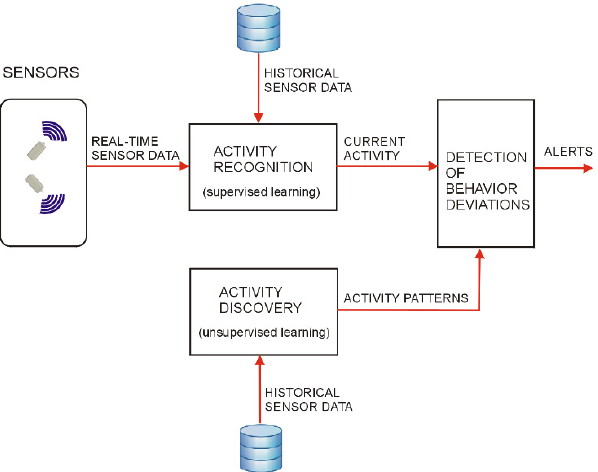
Figure 2. Typical structure of a system for detecting abnormal behavior based on the Activity Recog- nition Strategy.